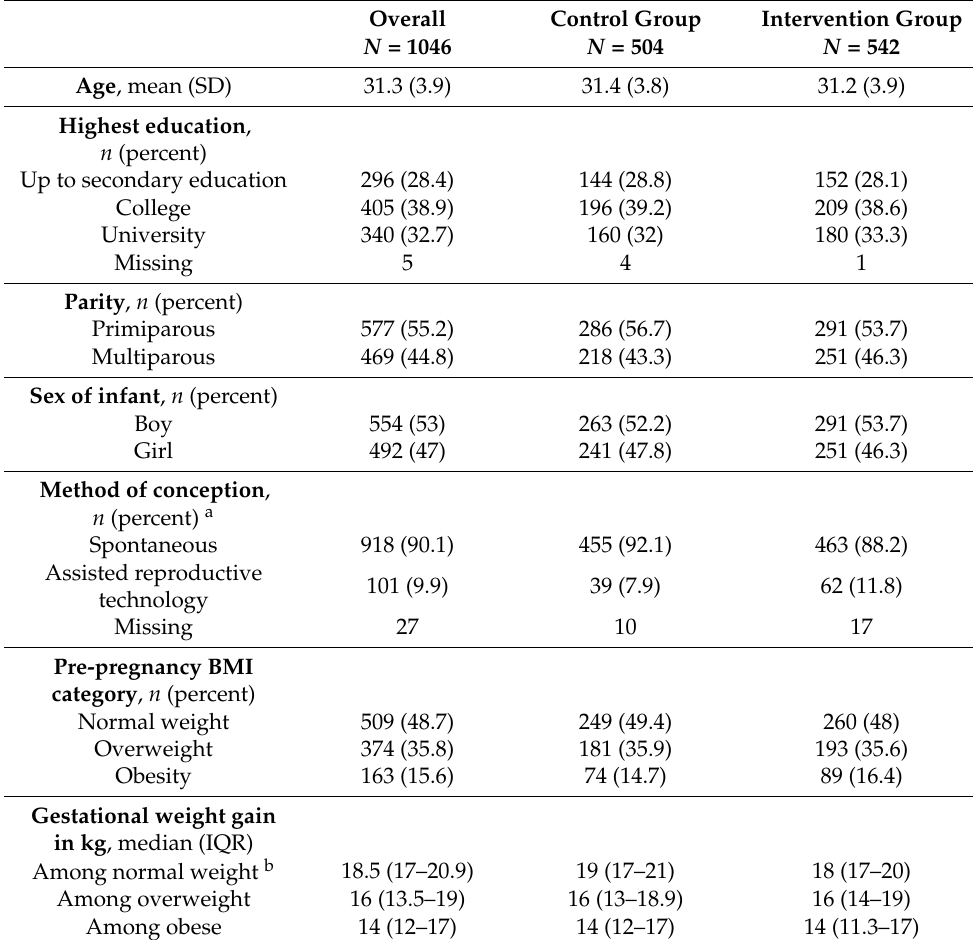
Table 1. Characteristics of the INTER-ACT